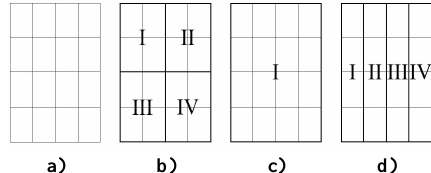
Figure 4. The coupling interface and interpolating schemes. ( a ) the coupling interface; ( b ) scheme with 9 interpolation basic nodes; ( c ) scheme with 4 interpolation basic nodes; ( d ) scheme with 10 interpolation basic nodes.